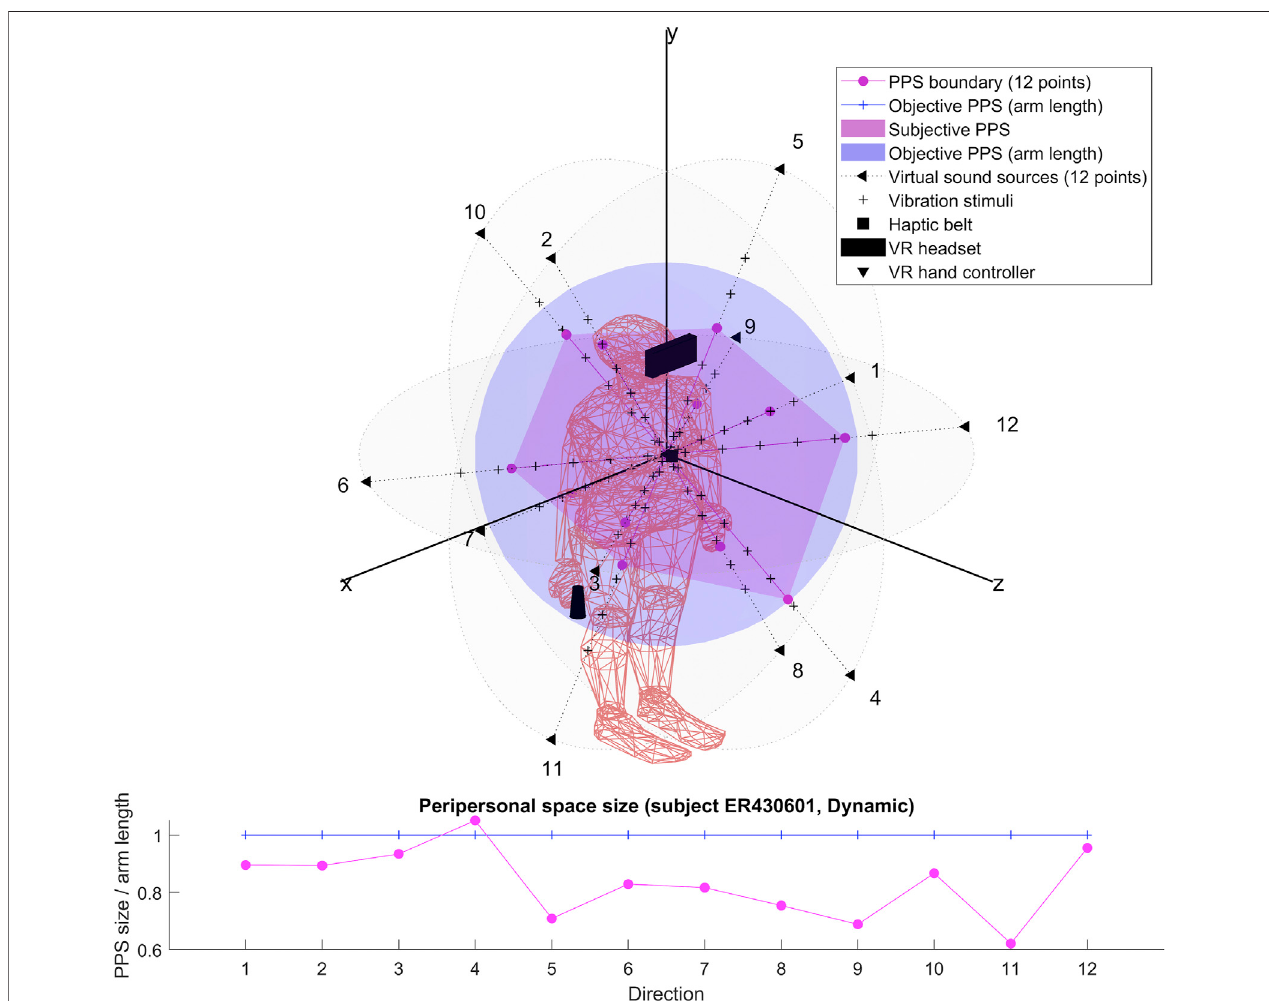
FIGURE 11 | PPS 3D representation for subject ER430601 dynamic